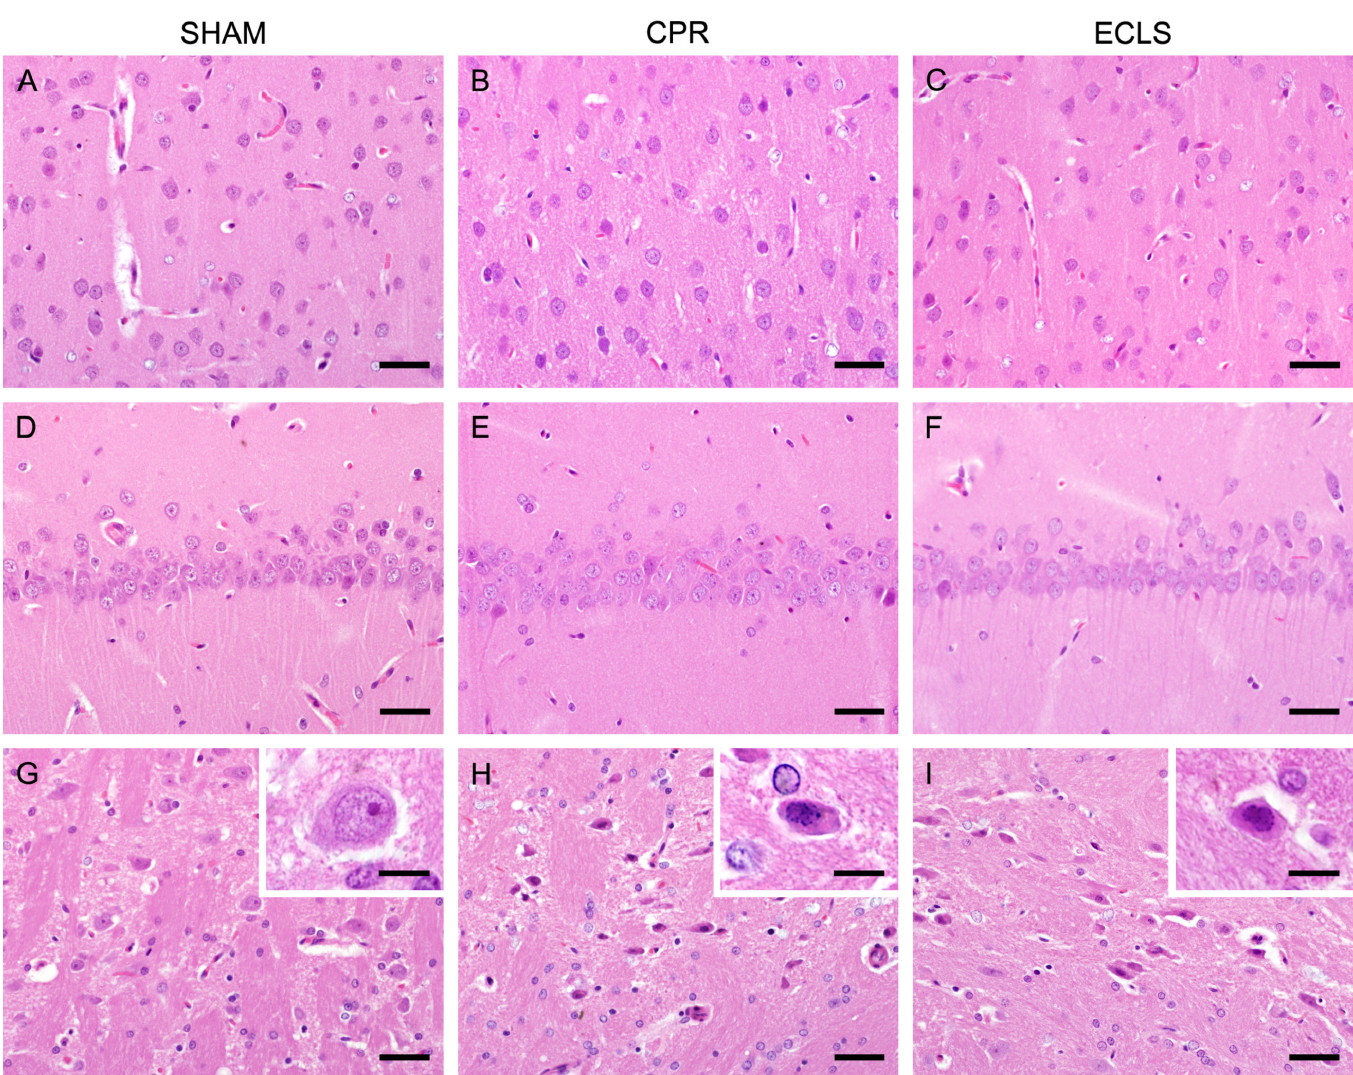
Fig 6. Representative pictures of cerebral cortex, hippocampal CA1 region and thalamic reticular nucleus. A-C: Cerebral cortex without lesions in sham (A), CPR (B) and ECLS (C) animals; H&E staining, bar = 40 μ m; D-F: Hippocampal CA1 region without lesions in sham (D), CPR (E) and ECLS (F) animals; H&E staining, bar = 40 μ m; G-I: Thalamic reticular nucleus, no lesions in sham animal (G), numerous shrunken neurons with condensation of nuclear chromatin in CPR (H) and ECLS (I) animals; H&E staining, bar = 40 μ m; inserts show close-up views of one neuron in the respective animal; H&E staining, bar = 10 μ